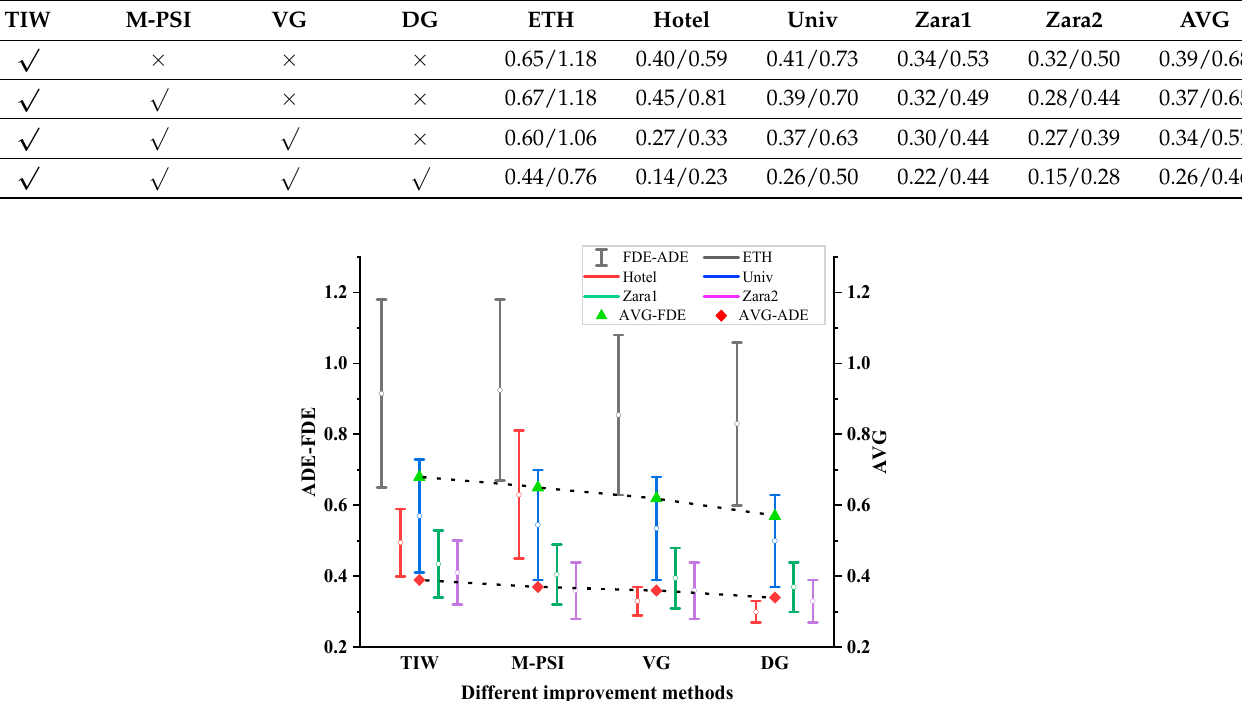
Table 4. The results of different pedestrian numbers obtained through ablation experiments.